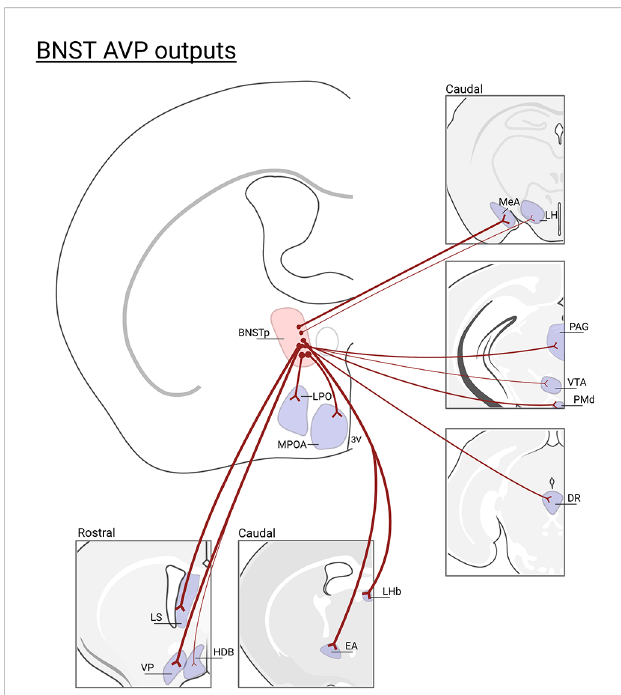
FIGURE 2 BNST AVP cell outputs . Brain regions that lose AVP innervation following gonadectomy (46) or BNST lesions (47, 64): (LS), lateral septum; (VP), ventral pallidum; (HBD)horizontal diagonal band; (MPOA) medial preoptic area; (LPO) lateral preoptic area; (LHb) lateral habenula; (EA) extended amygdala; (MeA) medial amygdala; (LH) lateral hypothalamus, (PAG) periaqueductal gray; (VTA) ventral tegmental area; (PMd) dorsal premammillary nucleus; (DR)dorsal raphe. Not all BNST AVP cell output regions are listed. Thickness of lines represents the density of AVP-ir fi ber innervation. Created with